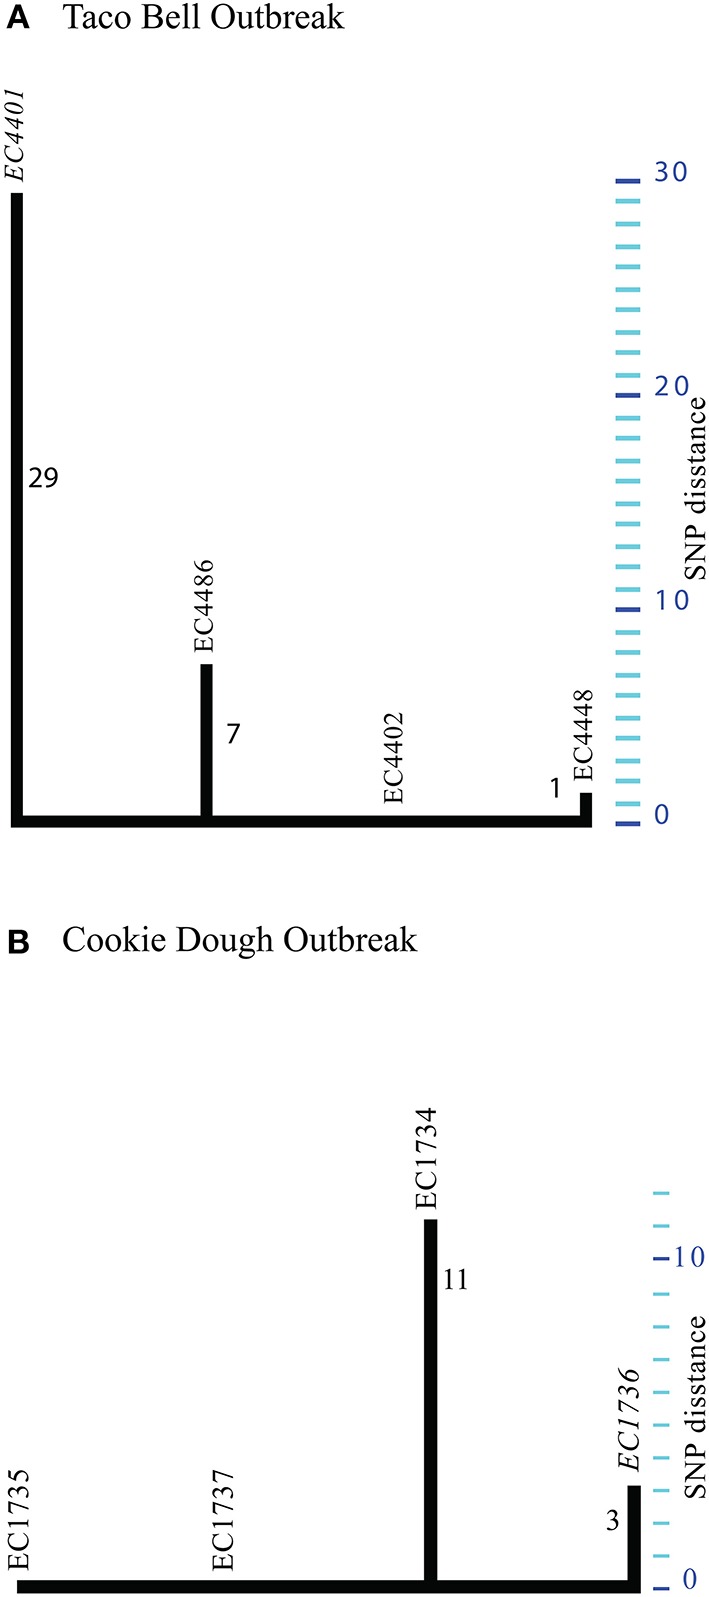
Phylogenetic tree for Taco Bell (A) and Cookie dough (B) outbreak strains. Maximum parsimony phylogeny computed from 37 TB and 14 CD SNPs identified in the respective outbreak associated strains. (A) By using a TB outbreak-specific reference (EC4401) we increased the phylogenetic resolution for these highly clonal strains. (B) Maximum parsimony phylogeny delineated from 14 SNPs discovered in the four CD outbreak associated strains. Strain EC1736 served as reference for the read based discovery. Majority of SNPs (#11) were specific to EC1734 and probably false positives from through assembly based discovery.